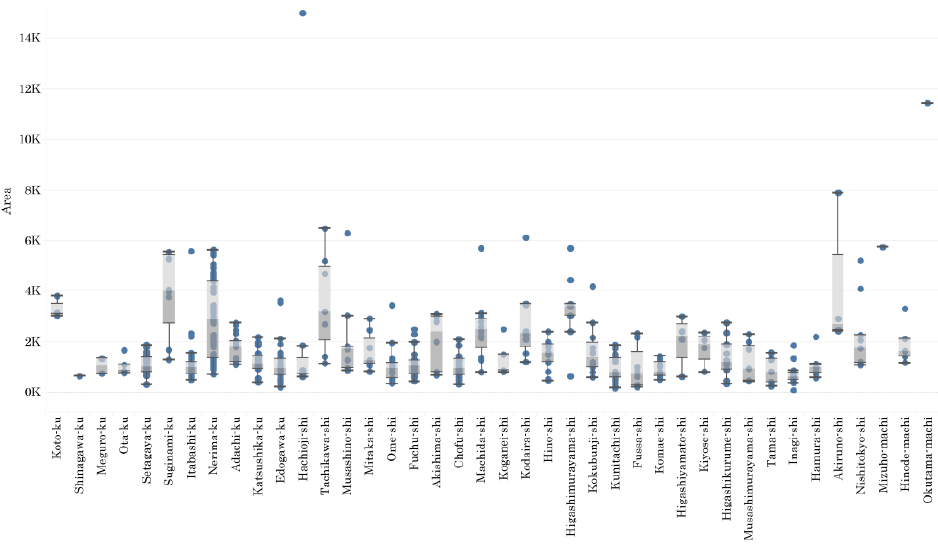
Figure 7. Box-and-whisker plot for the area(m 2 ) of AGs, was created by Tableau 2020.4.